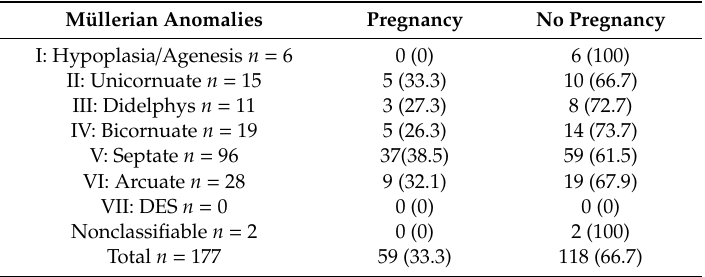
Table 3. Percentages of achieved pregnancy.